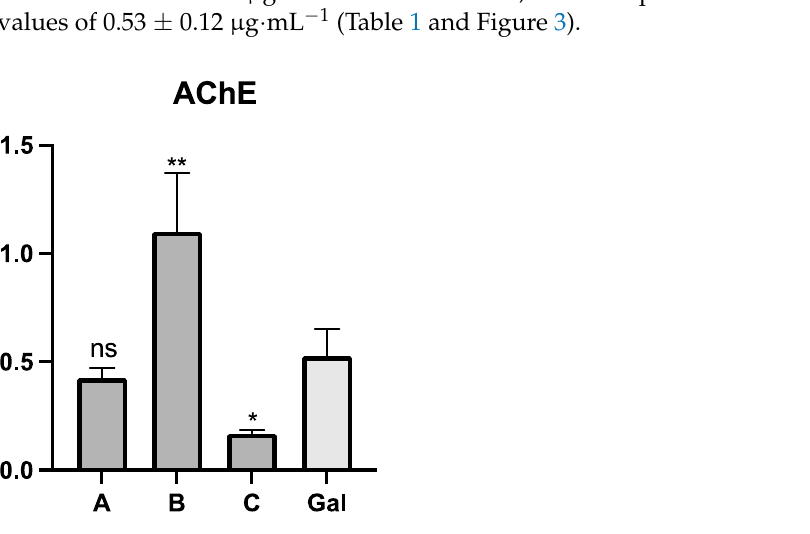
Figure 3. AChE inhibitory potential of Rauhia species. A = R. staminosa ; B = R. decora ; C = R. multiflora ; Gal = galanthamine; ** p < 0.01, * p < 0.1, and ns (not significant). The high amount and diversity of galanthamine-type alkaloids detected in R.